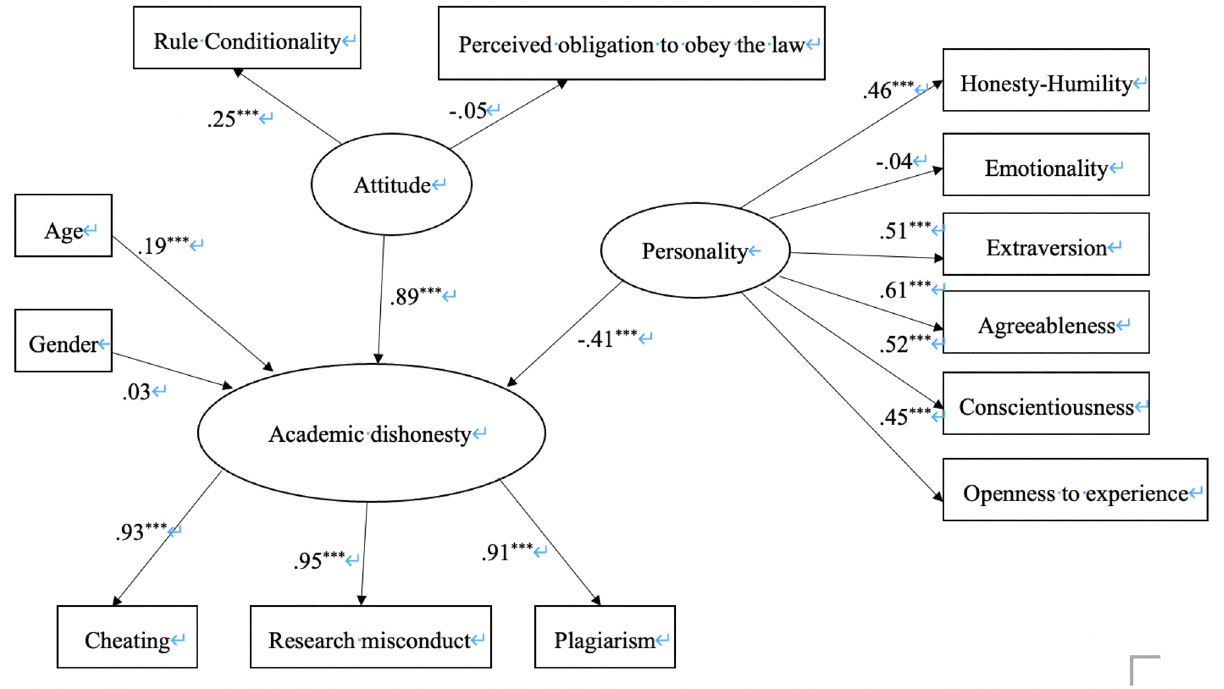
Figure 1. Structural model for determinants of academic